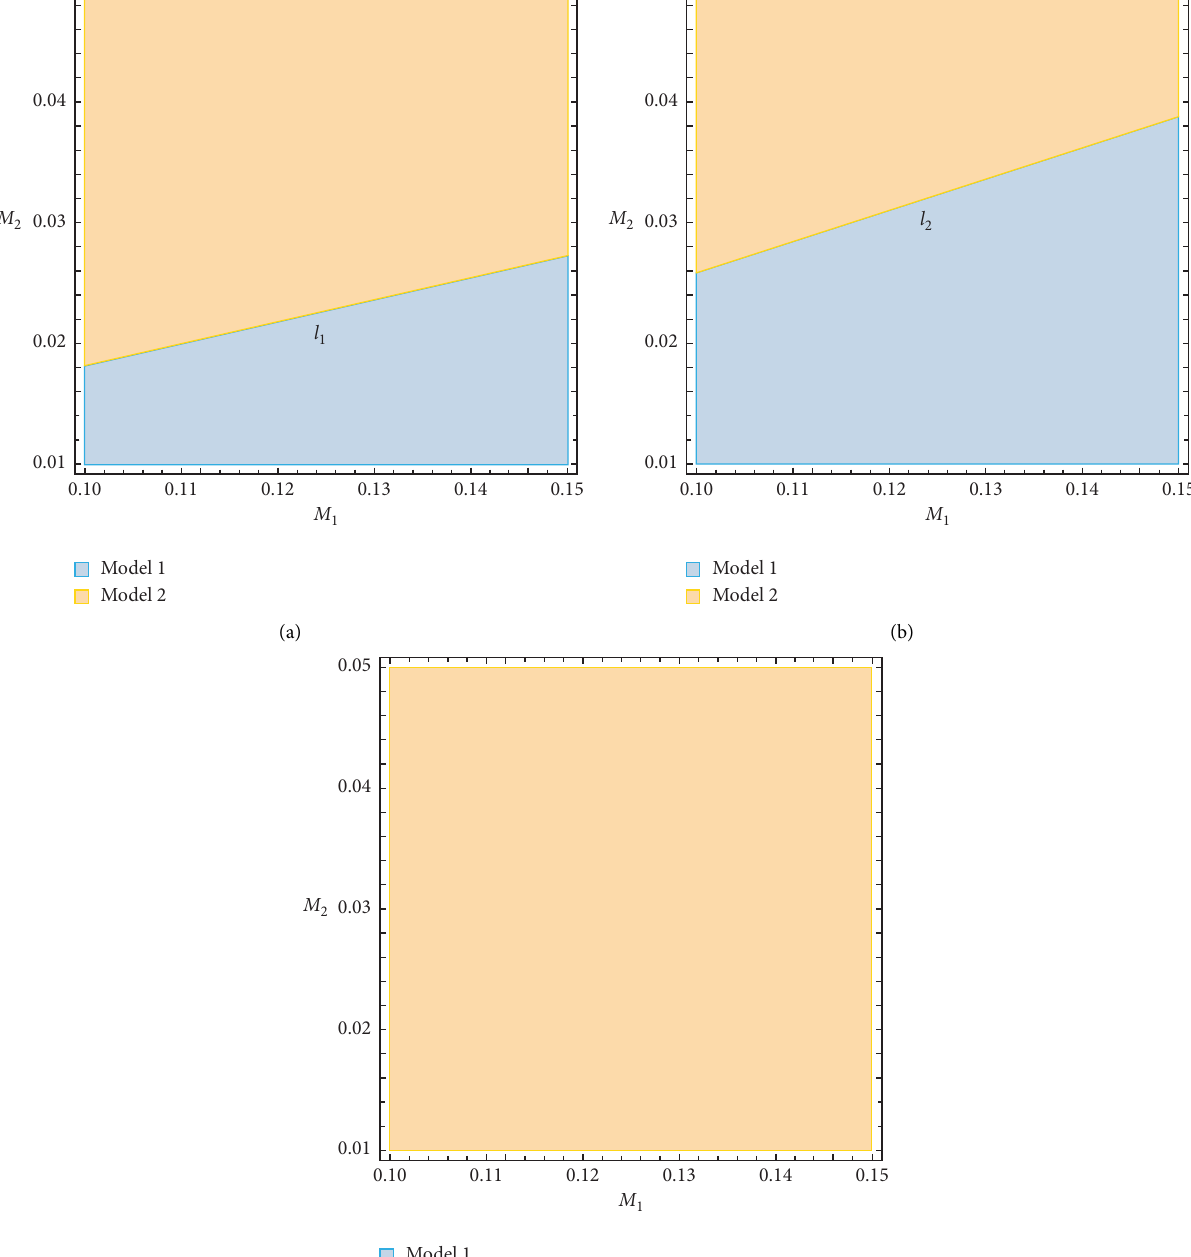
& M increasing. (a) Third-party offline recycler, (b) third-party online recycler, and 1 2